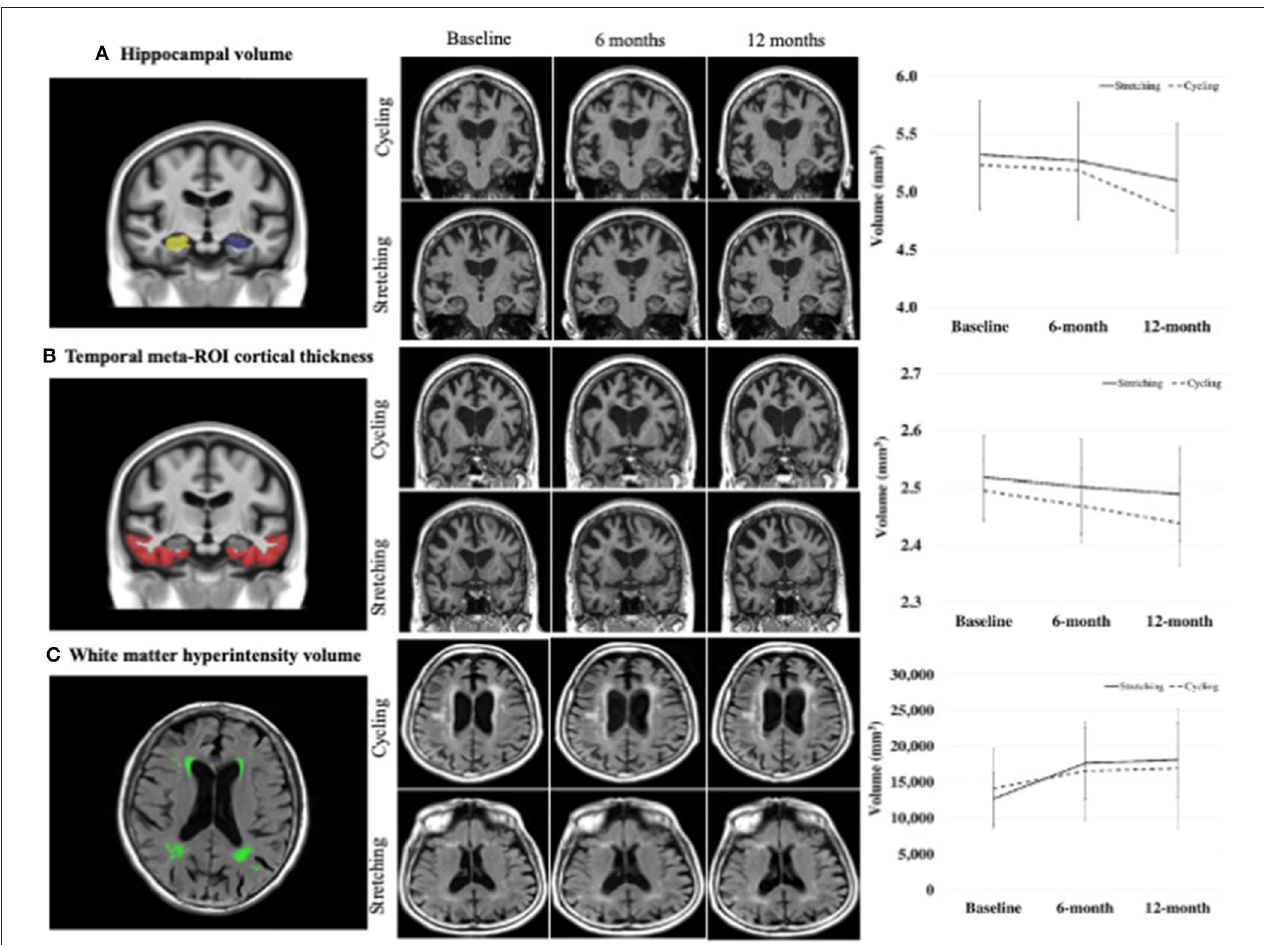
FIGURE 2 | Comparison of changes in MRI biomarkers between